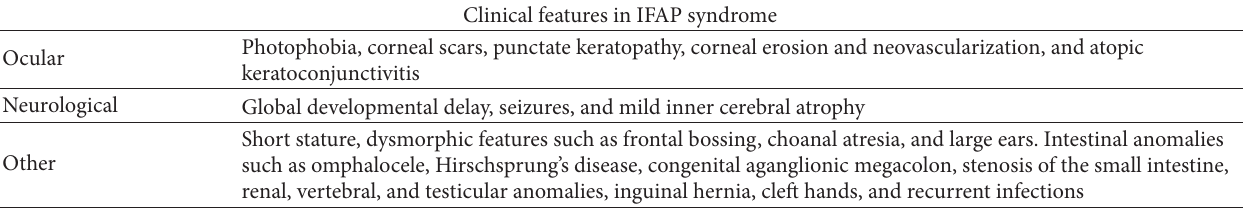
Clinical features in IFAP